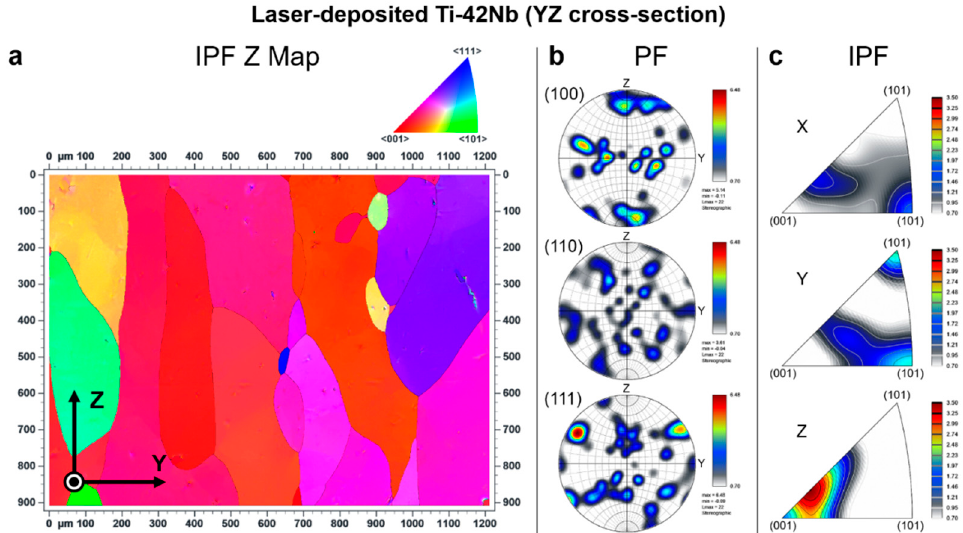
Figure 11. Electron backscatter diffraction (EBSD) results at YZ cross-section: ( a ) inverse pole figure Z map (IPF Z Map), ( b ) pole figures (PF), and ( c ) inverse pole figures (IPF).